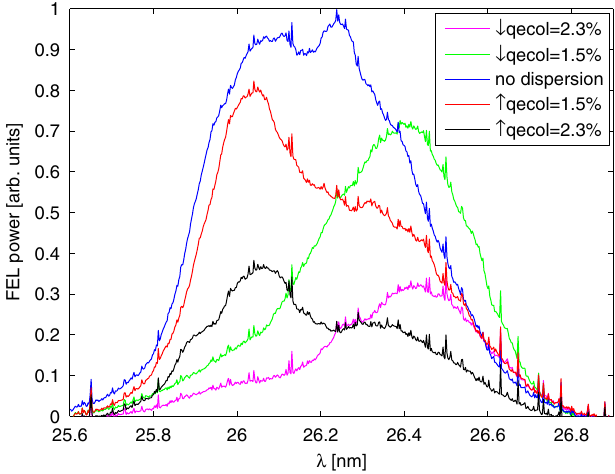
FIG. 15. (Color) Radiation spectrum measurements for different dispersion scenarios.